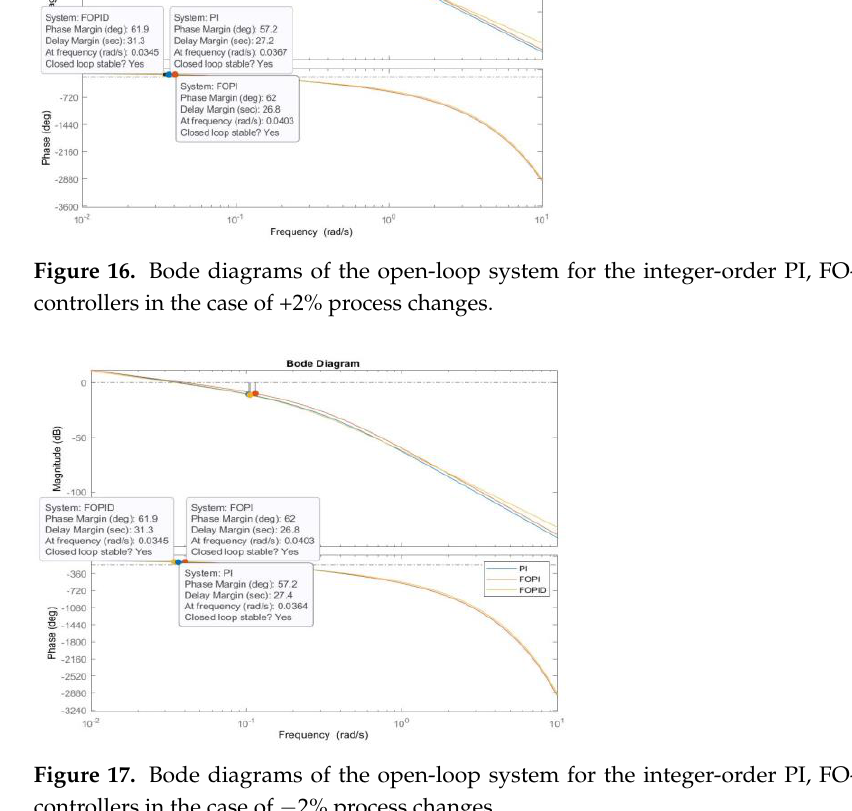
Figure 17. Bode diagrams of the open-loop system for the integer-order PI, FO-PI, and FO-PID controllers in the case of −2 % process changes.